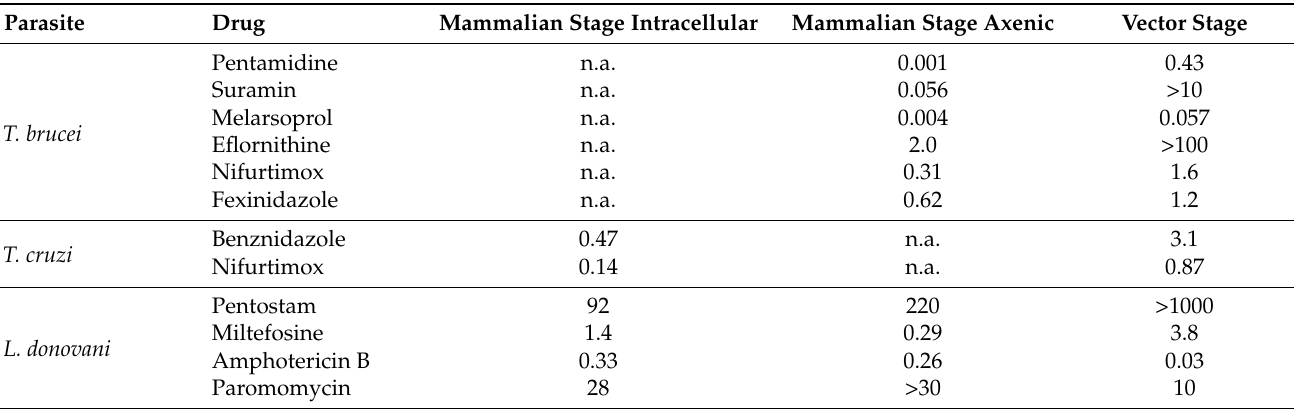
Table 2. Standard drugs and sensitivity of mammalian vs. insect stages. All values are in vitro IC 50 in µ g/ml, original data from our trypanosomatid drug screening